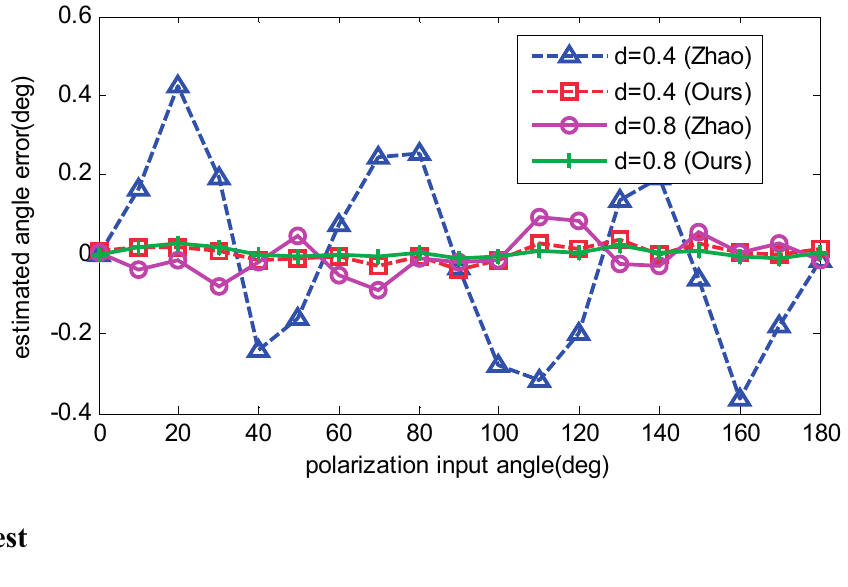
Figure 8. Estimated angle error comparison of post-calibration with different polarization